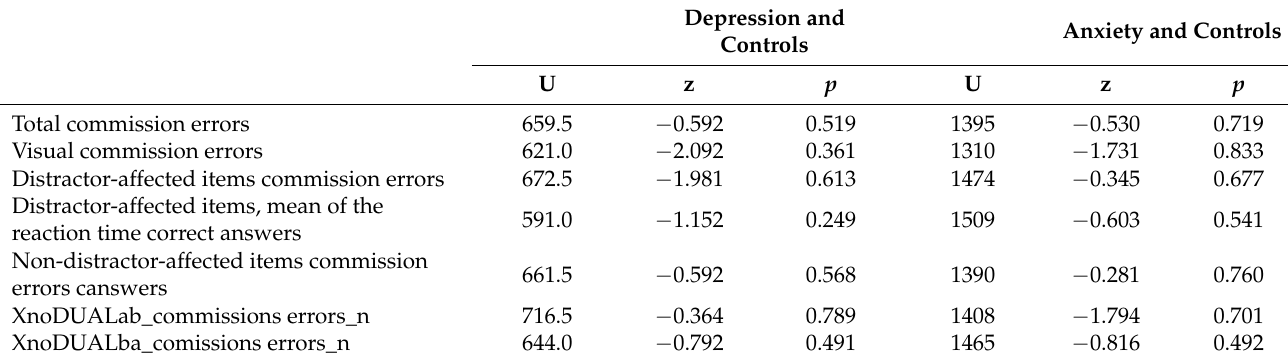
Table 4. Contrast of means between group with depression and anxiety and controls. Inhibitory